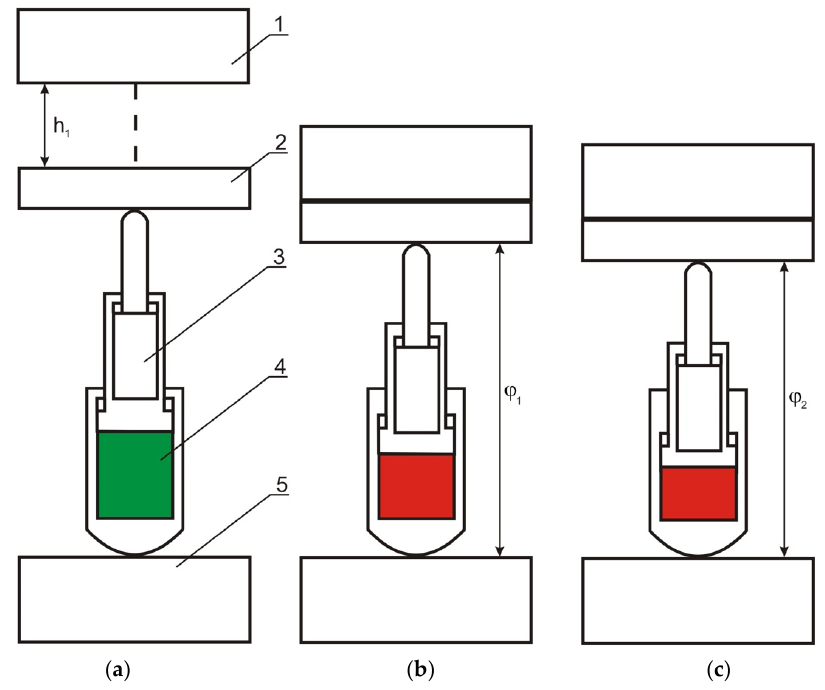
Figure 3. Schematic of the test model: ( a ) position of the leg before loading, where: 1—impact mass of the traverse m 1 , h 1 —height for the falling mass, mass of the traverse m 2 , 3—hydraulic leg, 4—working pressure, 5—foundation of the stand; ( b ) dynamic increase in fluid pressure, where φ 1 —the first slide of the leg, ( c ) final increase in fluid pressure, where φ 2 —the second slide of the leg.